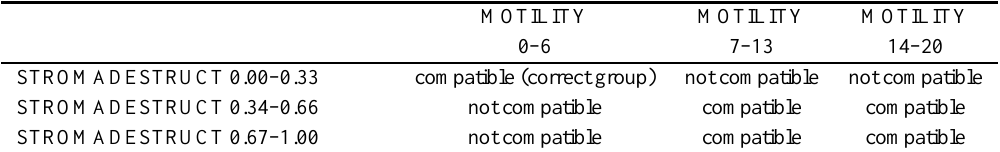
Pattern interpretation in simulated tumour patterns using cellular automata. Variation of multiple parameters. Example of a case compatible with the whole range of MOTILITY and STROMADESTRUCT. Though no value of MOTILITY or STROMADESTRUCT could be ruled out, still certain constellations of MOTILITY and STROMADESTRUCT appeared to be incompatible with this particular pattern. In plain language, the particular pattern seems to be compatible with either low motility and a low degree of stroma destruction, or a high degree of motility and stroma destruction, but is incompatible with high motility together with low destruction or low motility with high destruction.